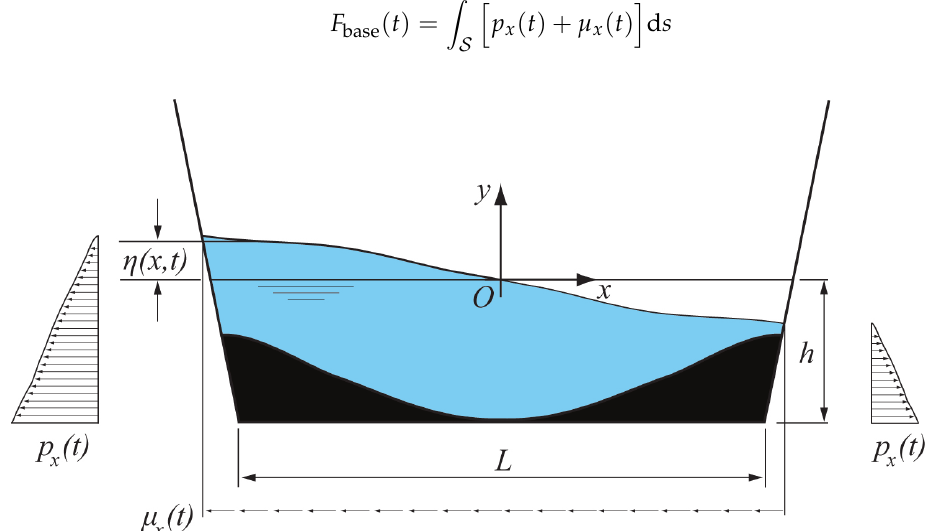
Figure 1. Schematic illustration of the sloshing phenomenon and the horizontal dynamic pressures generating on the sides of a tank having generic bottom